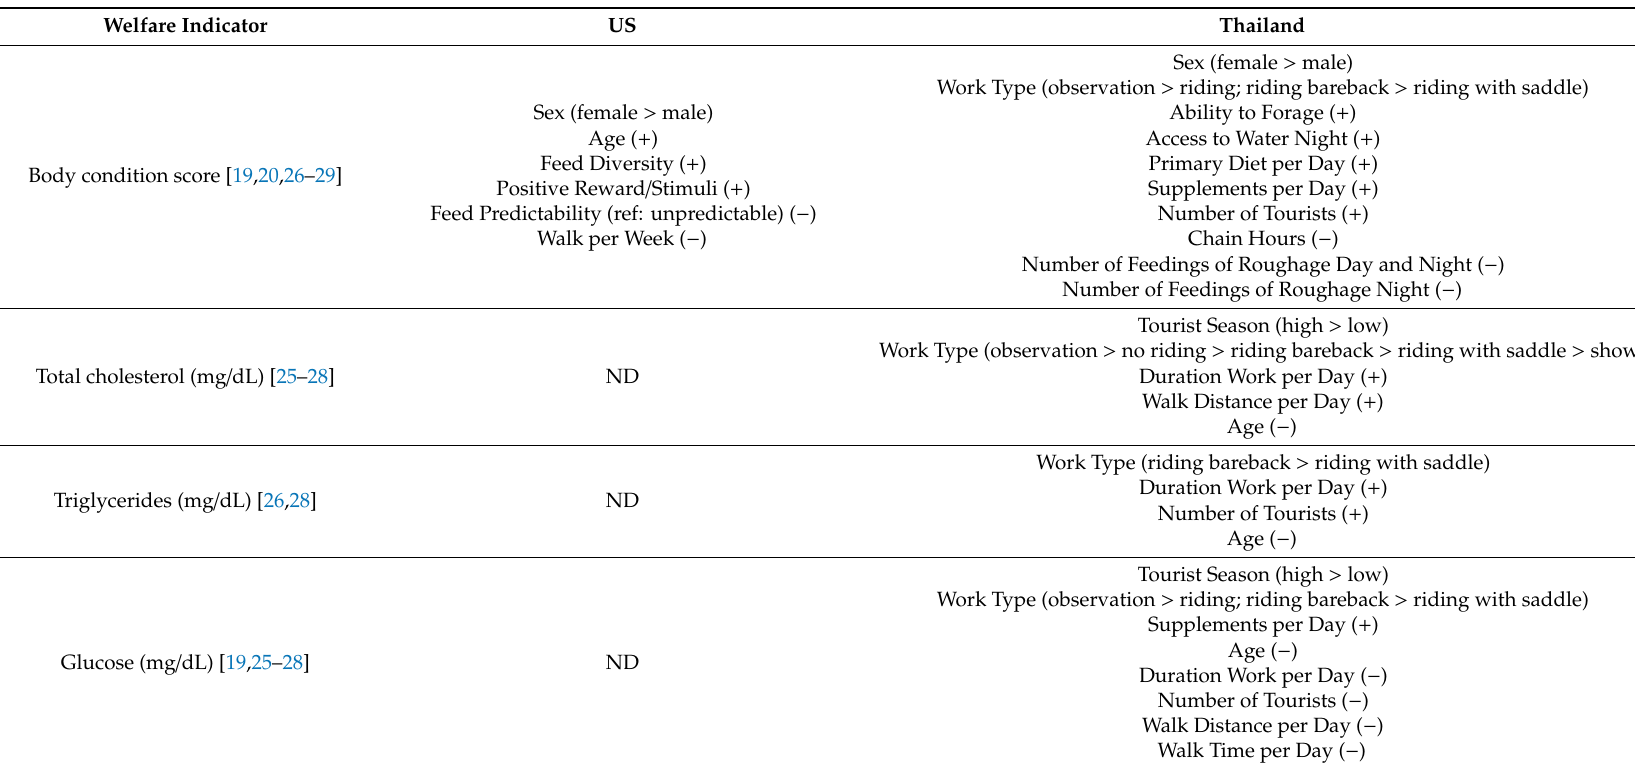
Table 3. Comparison of demographic, management, and husbandry factors (independent variables), with positive ( + ) and negative ( − ) associations to welfare indicators in Asian elephants from epidemiological studies conducted in North America and Thailand. Includes factors significant in univariate ( p < 0.15) and multivariable ( p < 0.05)